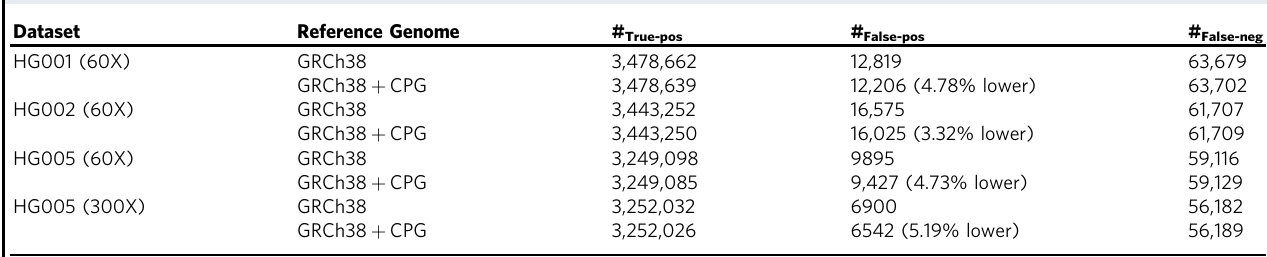
Table 2 Variant calling performance with different reference